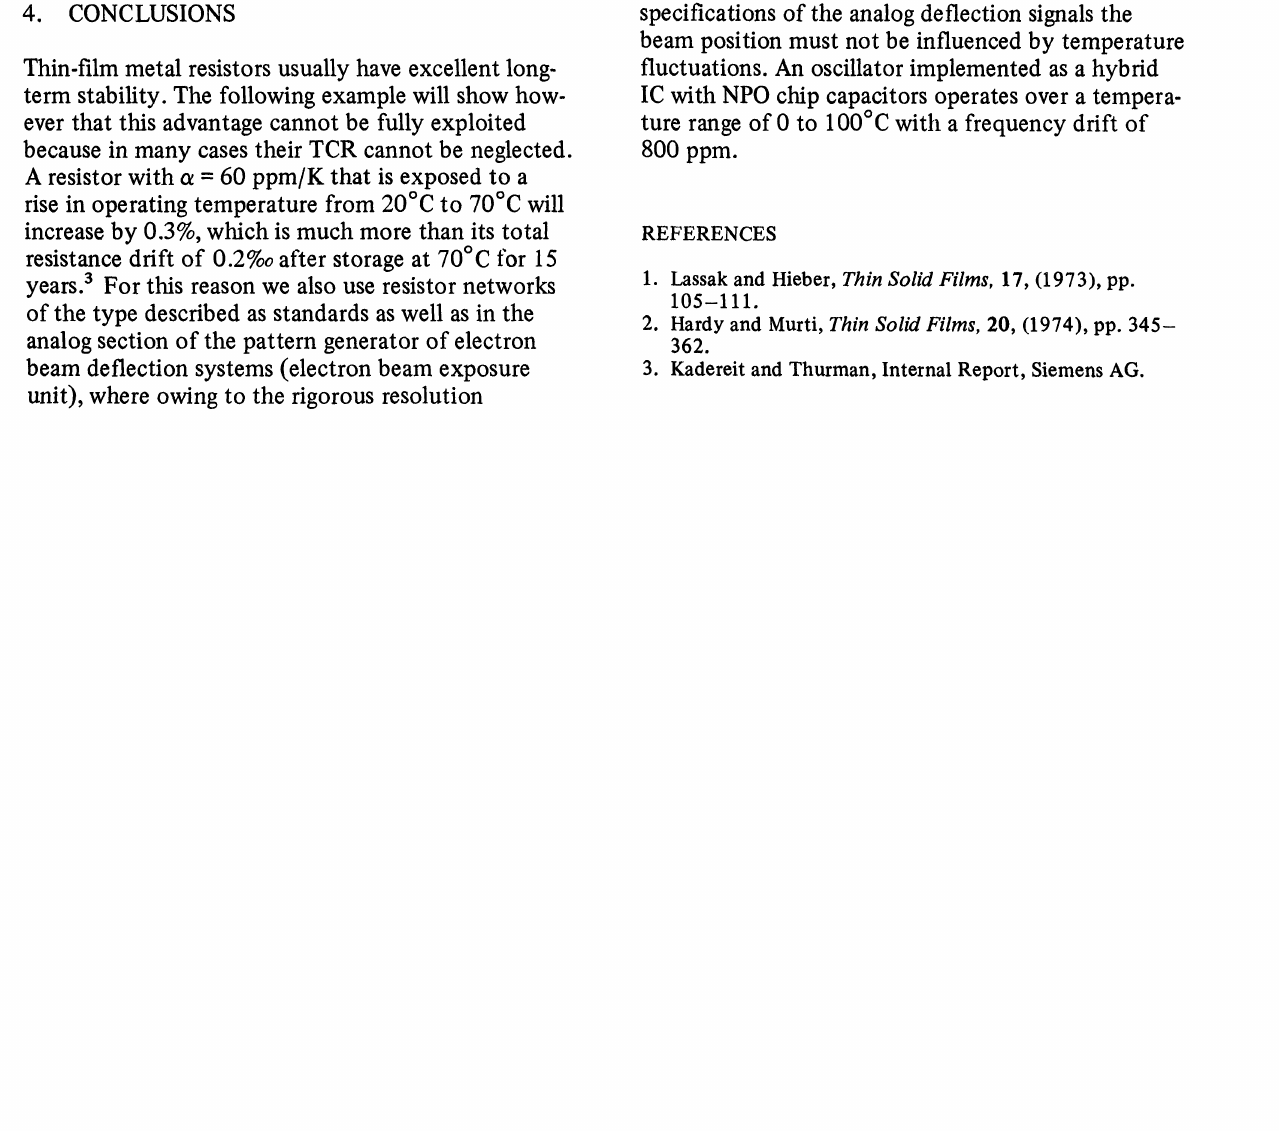
FIGURE 6 O2/At peak ratio during a complete